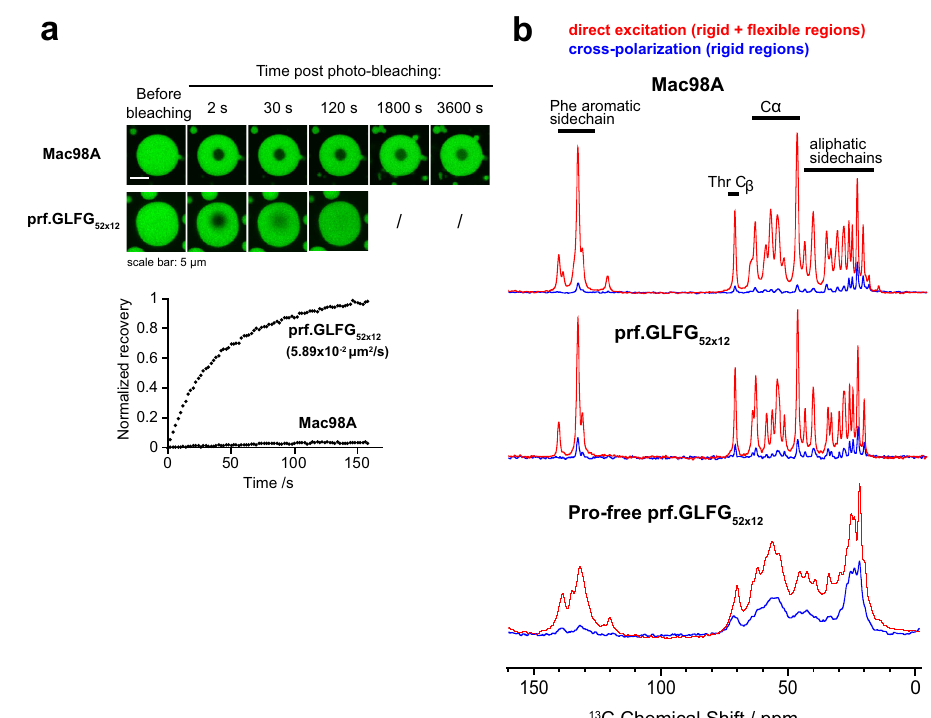
Fig. 2 Phase-separated Nup98 FG domains show different behaviours at different scales. a Recovery after bleaching of FG phases assembled from Mac98A FG domain or prf.GLFG 52×12 spiked with 2.5% Atto488-coupled FG domains (of the same species). Bleached area: manually de fi ned to be circular with a diameter of ~3 μ m. Fluorescence recovery over time is shown (recovery is normalized to 1 for a complete recovery). For prf.GLFG 52×12 the translational diffusion coef fi cient is shown, as derived from fi tting the dataset to a theoretical exponential recovery curve (Methods). The Mac98A FG domain is essentially immobile. Although a slight increase of signal inside the bleached area was observed e.g., at 1800 s and 3600 s, this is likely due to self-recovery of the bleached fl uorophore molecules but not due to diffusive recovery, as a change of postbleach pro fi le 91 is not observed. b 1D 13 C spectra of FG phases assembled from Mac98A FG domain (top), prf.GLFG 52×12 (middle), and a thio fl avin-T-positive, proline-free variant of prf.GLFG 52×12 : (GGLFGGATNSQT) 52 (bottom), obtained by MAS NMR (at 36 °C, 20 kHz MAS). In red, the signal from direct excitation (showing all 13 C atoms), in blue, the cross-polarization (CP) spectrum (selective towards rigid parts of the samples). All spectra were obtained by averaging 1024